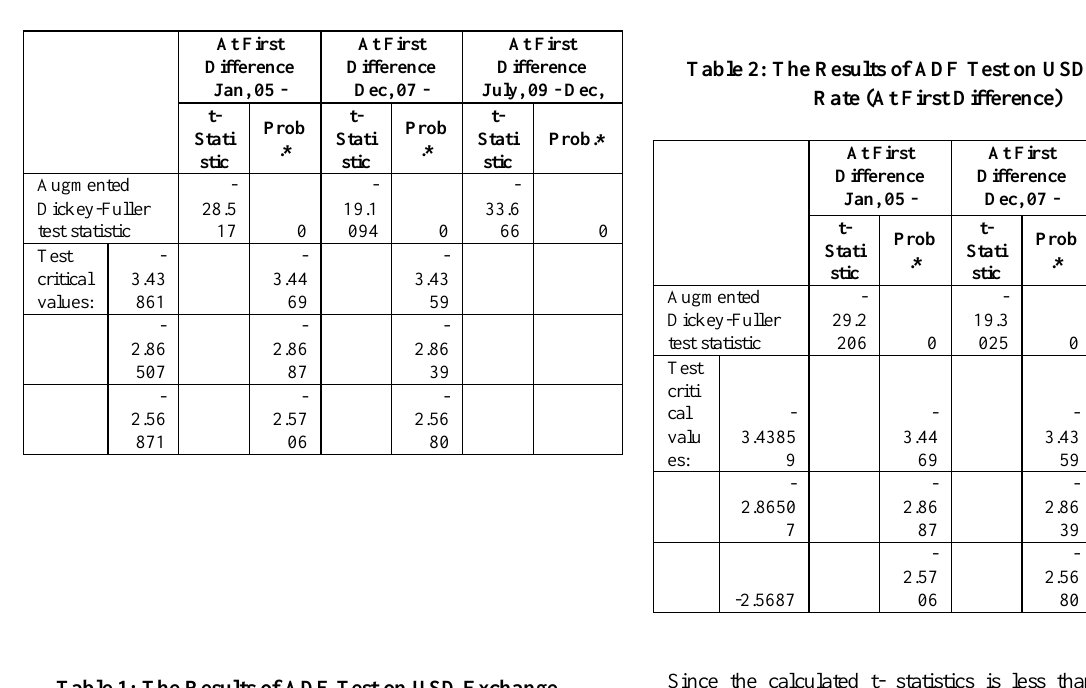
Table 1: The Results of ADF Test on USD Exchange